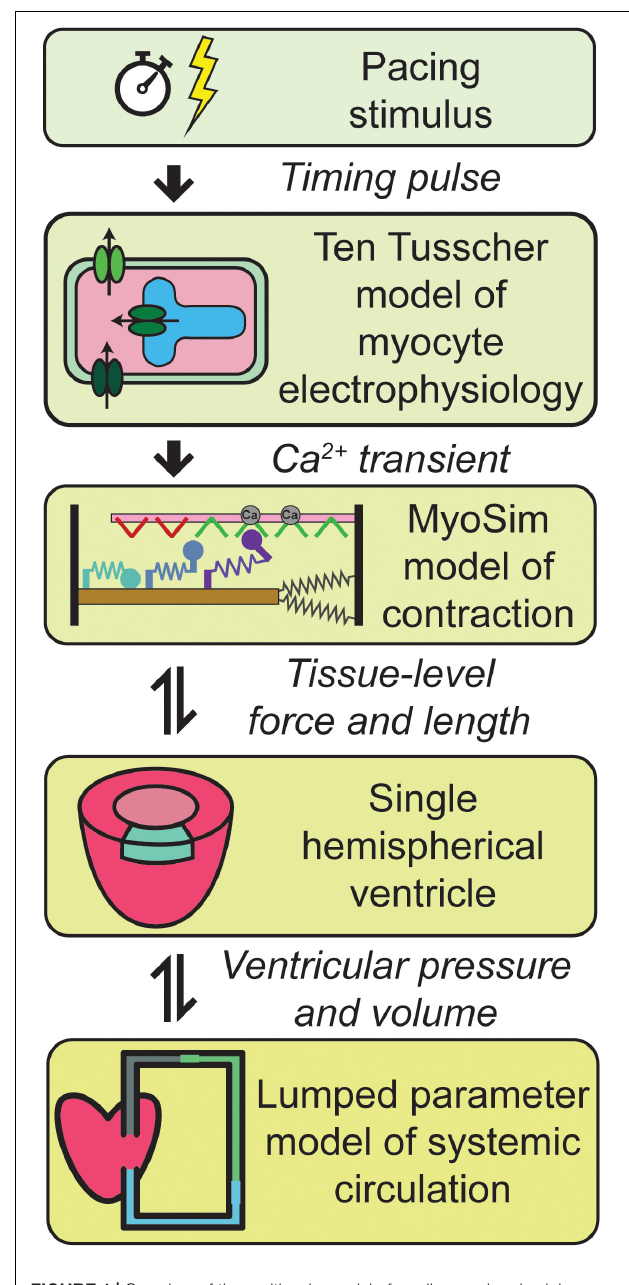
FIGURE 1 | Overview of the multiscale model of cardiovascular physiology. Ca 2 + transients simulated using a well-established model of the electrophysiology of a human cell (ten Tusscher et al., 2004) drove a contractile model implemented using MyoSim (Campbell, 2014; Campbell et al., 2018). The pressure and volume in the hemispherical ventricle were calculated from the contractile element’s force per unit area and length. The ventricle pumped blood through a systemic circulation that was mimicked using zero dimensional compartments. Additional details are provided in section “Materials and